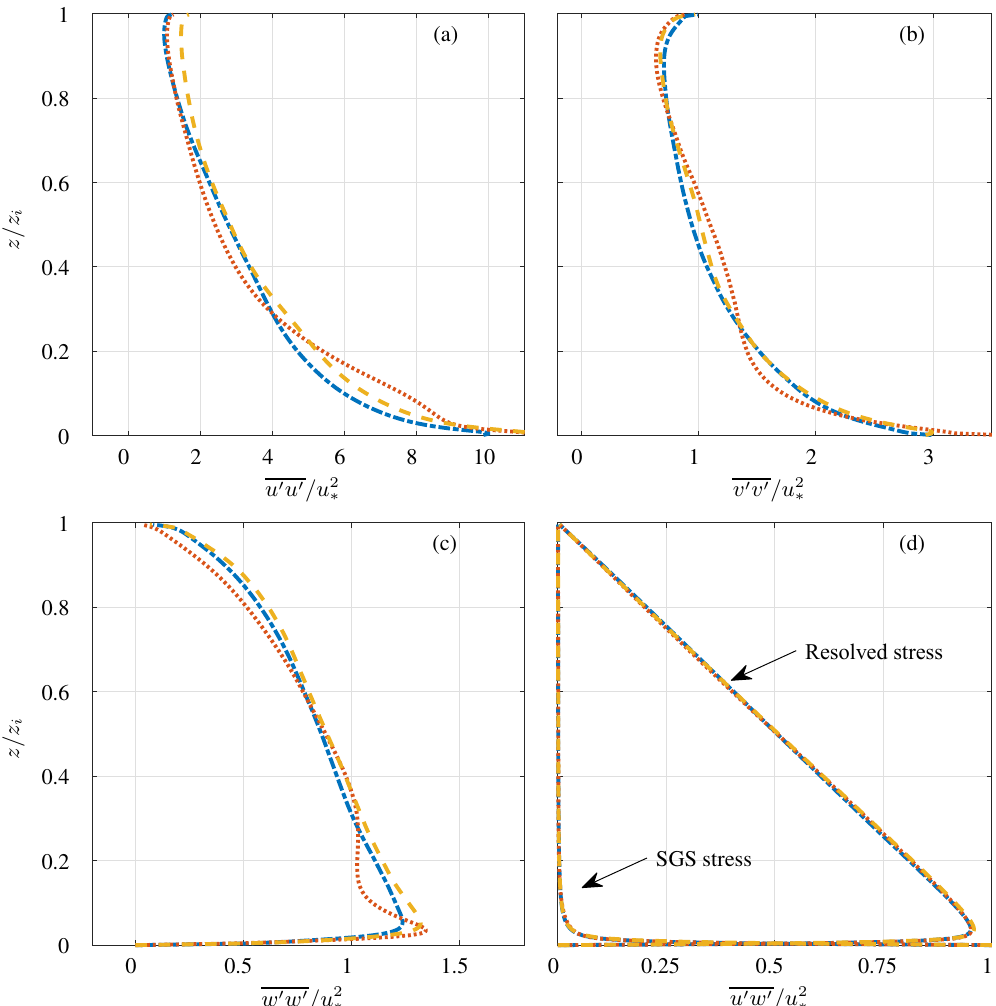
Figure 8. Profiles of the non-dimensional variances (a–c) and shear stress (d) using a numerical resolution of 256 3 for the three different dealiasing methods: the 3 / 2 rule as the blue dot–dashed line, the FT method as the red dotted line, and the FS method as the yellow dashed